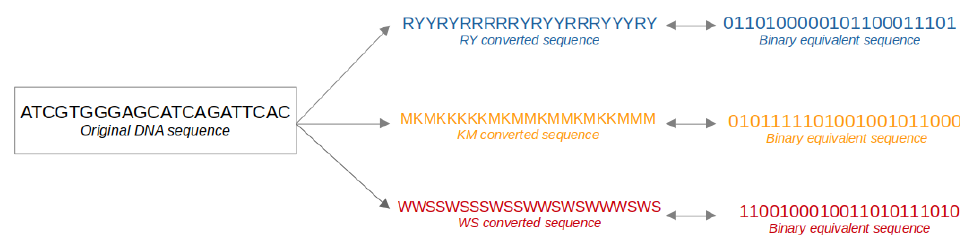
Figure 2. Conversion of original DNA sequence into binary sequences. The original DNA sequence is converted or translated into three different sequences. The diagram shows conversion to a purine/pyrimidine (RY) sequence, keto/amino (KM) sequence, and weak/strong (WS) sequence. It also depicts an equivalent binary sequence for each represented by zero or one, where the assignment of either a zero or one is arbitrary. Each of the RY, KM, and WS conversions, is a separate type of conversion to a binary ‘type’ of sequence. RY sequence: A and G are converted to R, and C and T are converted to Y; KM sequence: A and C are converted to M, and G and T are converted to K; WS sequence: A and T are converted to W, and C and G are converted to S.